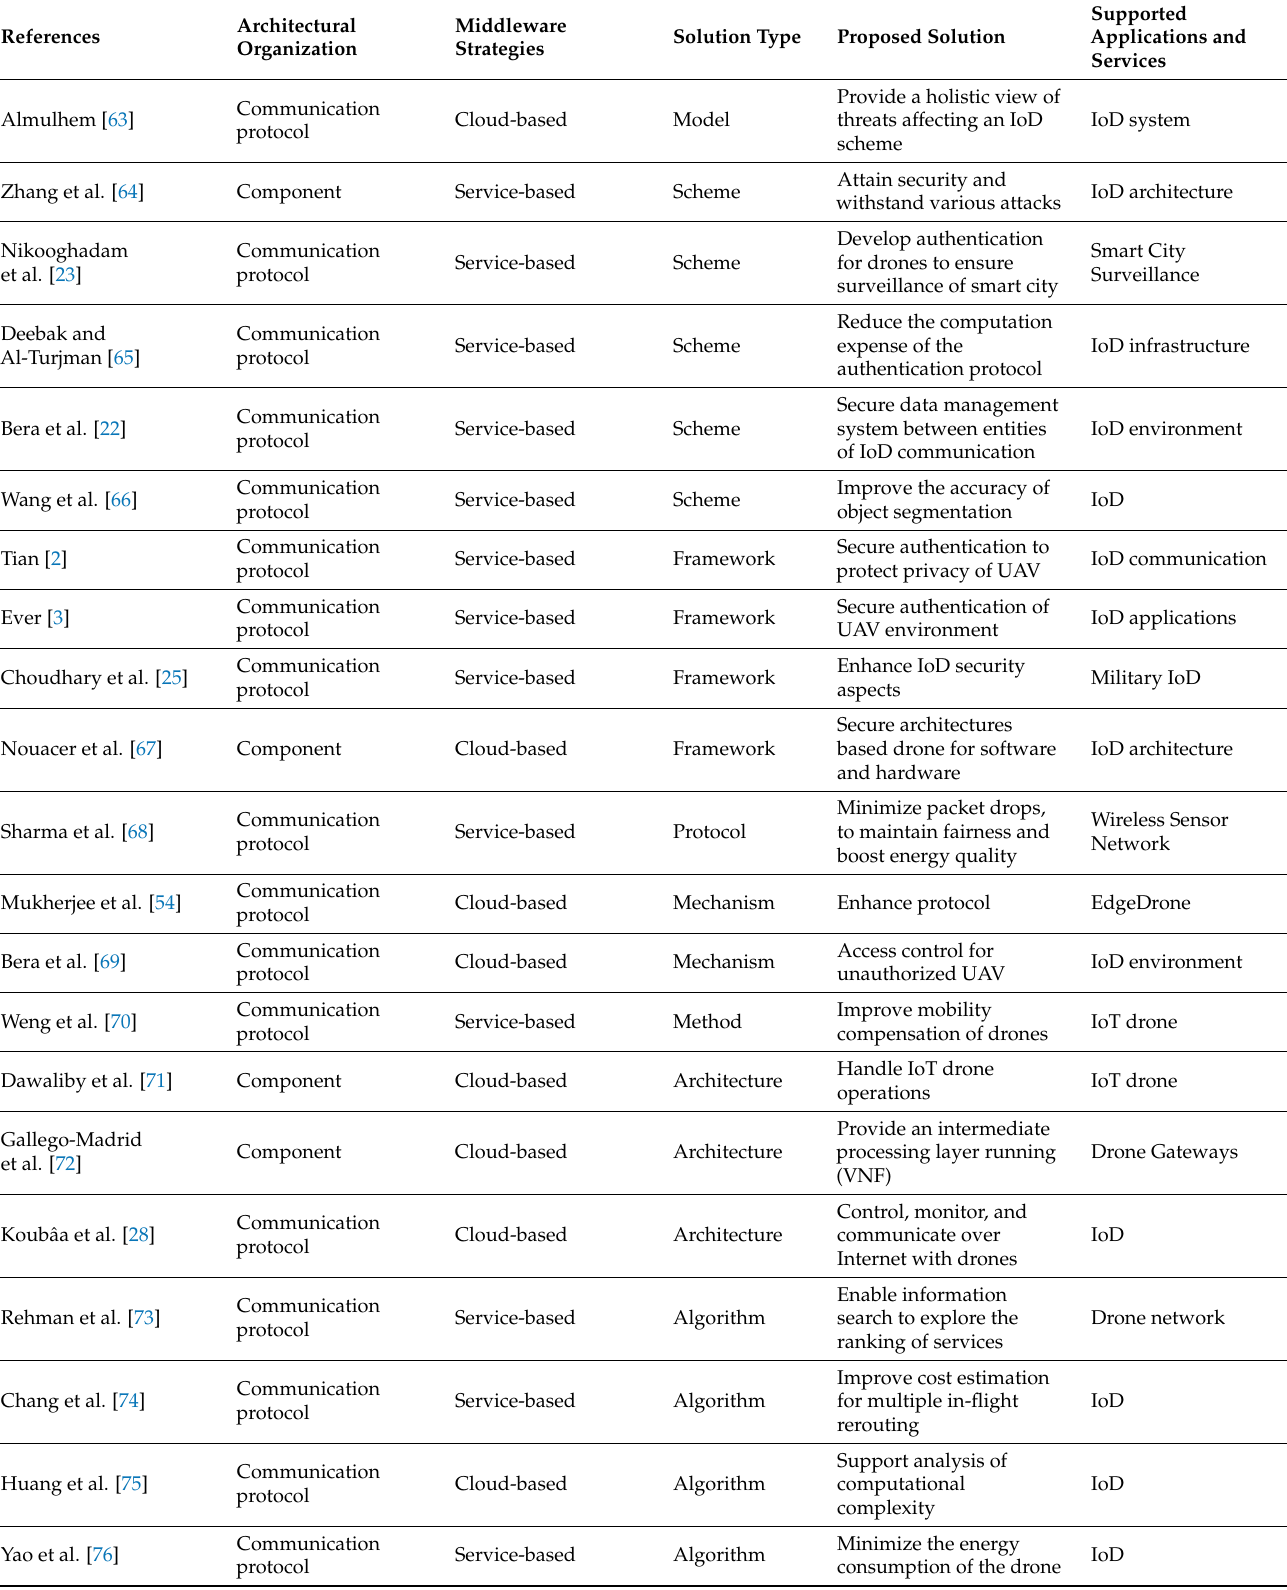
Table 4. Recent advancements in